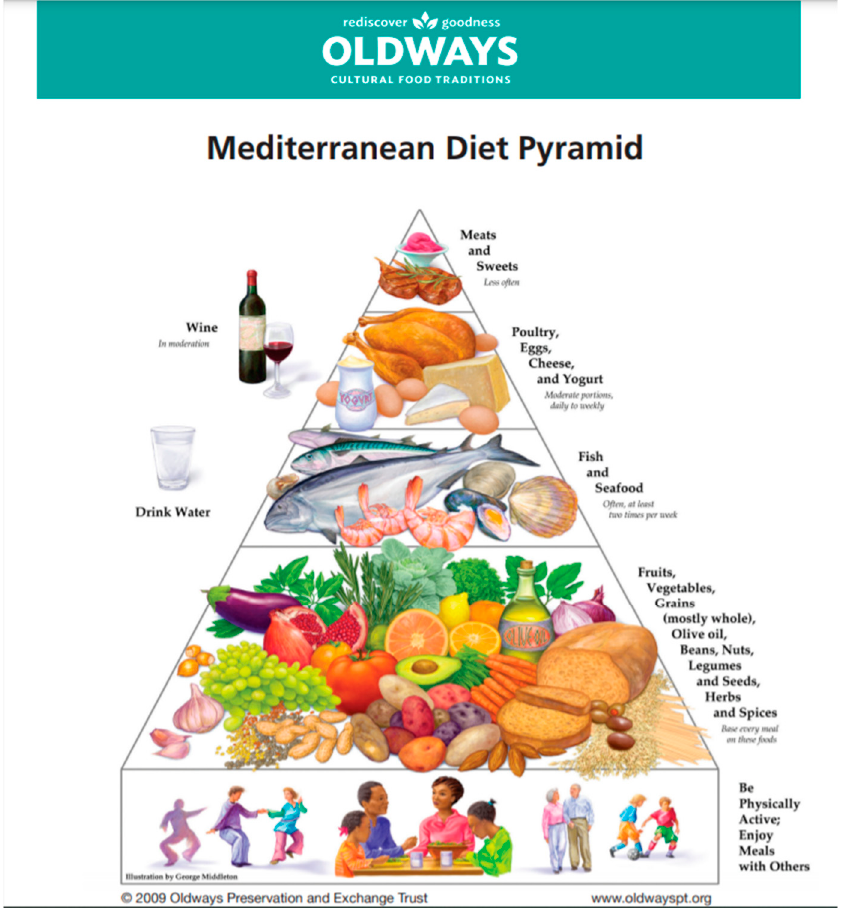
Figure 1. The initial concept for Mediterranean diet pyramid. In 1993, Oldways created the Mediterranean Diet Pyramid—in partnership with the Harvard School of Public Health and the World Health Organization (WHO).